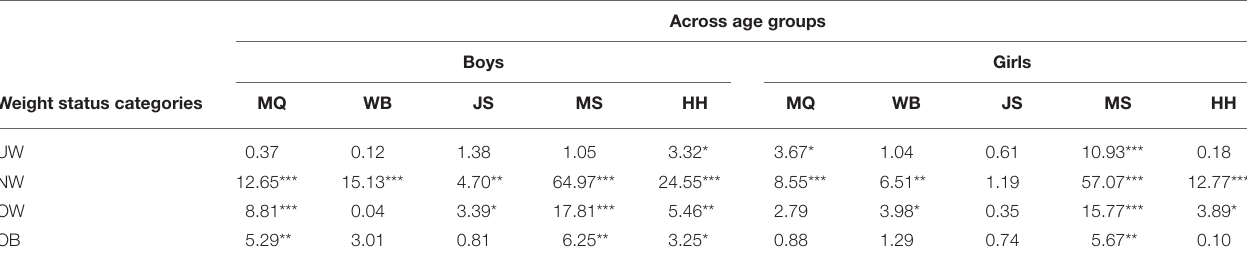
TABLE 4 | F-values and significance levels of differences in the total MQ and subtest scores of the KTK across age groups by gender classes and weight status categories. Across age groups Boys